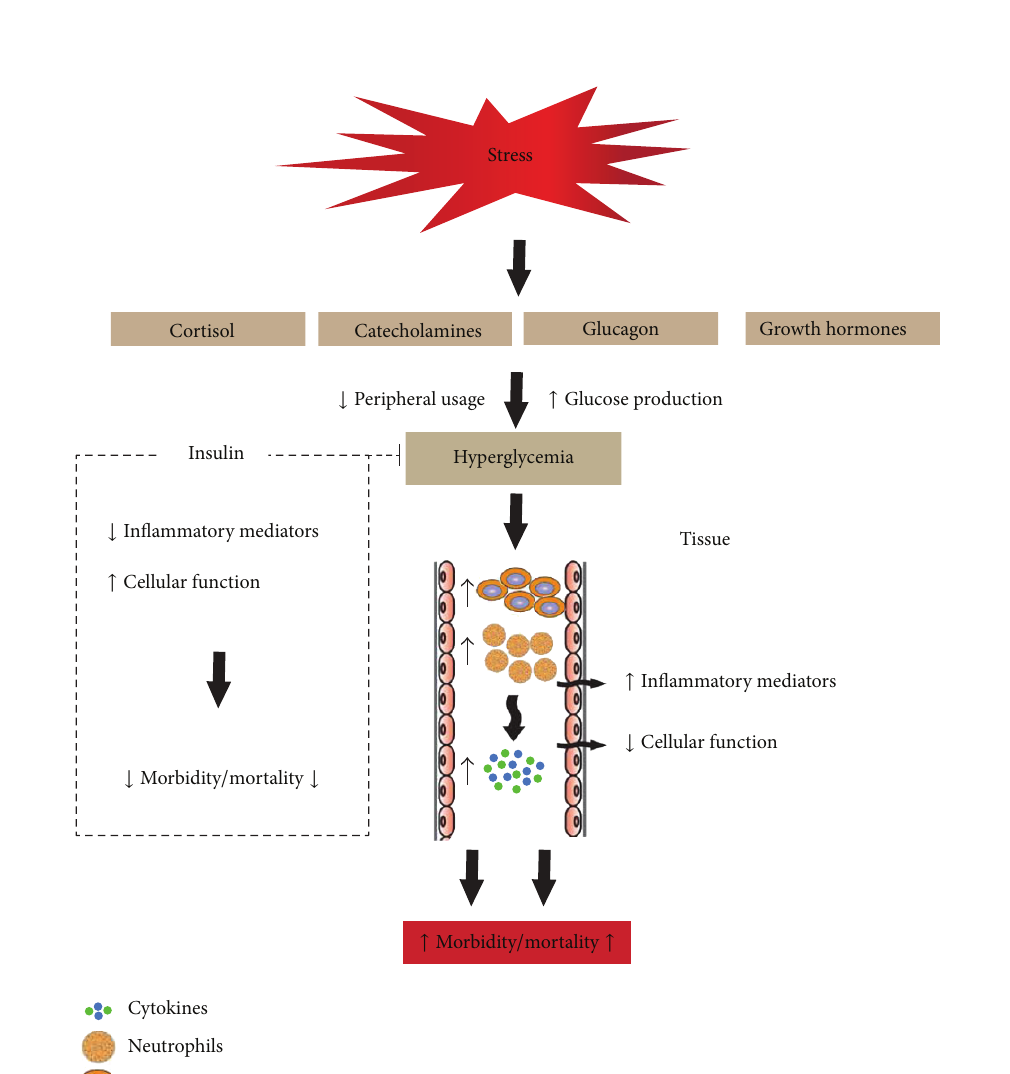
Figure 1: Schematic summary of hyperglycemia and insulin treatment regulation of innate immune cells. Overwhelming stress resulted from critical illness, such as severe burn, major surgery, or sepsis stimulates the release of cortisol, catecholamines, glucagon, and growth hormone, which increase hepatic glucose production and impair glucose consumption by peripheral tissues. Long-term stress-induced hyperglycemia induces hyperproinflammatory responses and depressed cell functions, which is linked to increased risk of mortality and morbidity. Insulin plays a different role in regulating innate immune cells including monocytes, macrophages, and neutrophils. It generally improves their cellular activities and attenuates their inflammatory